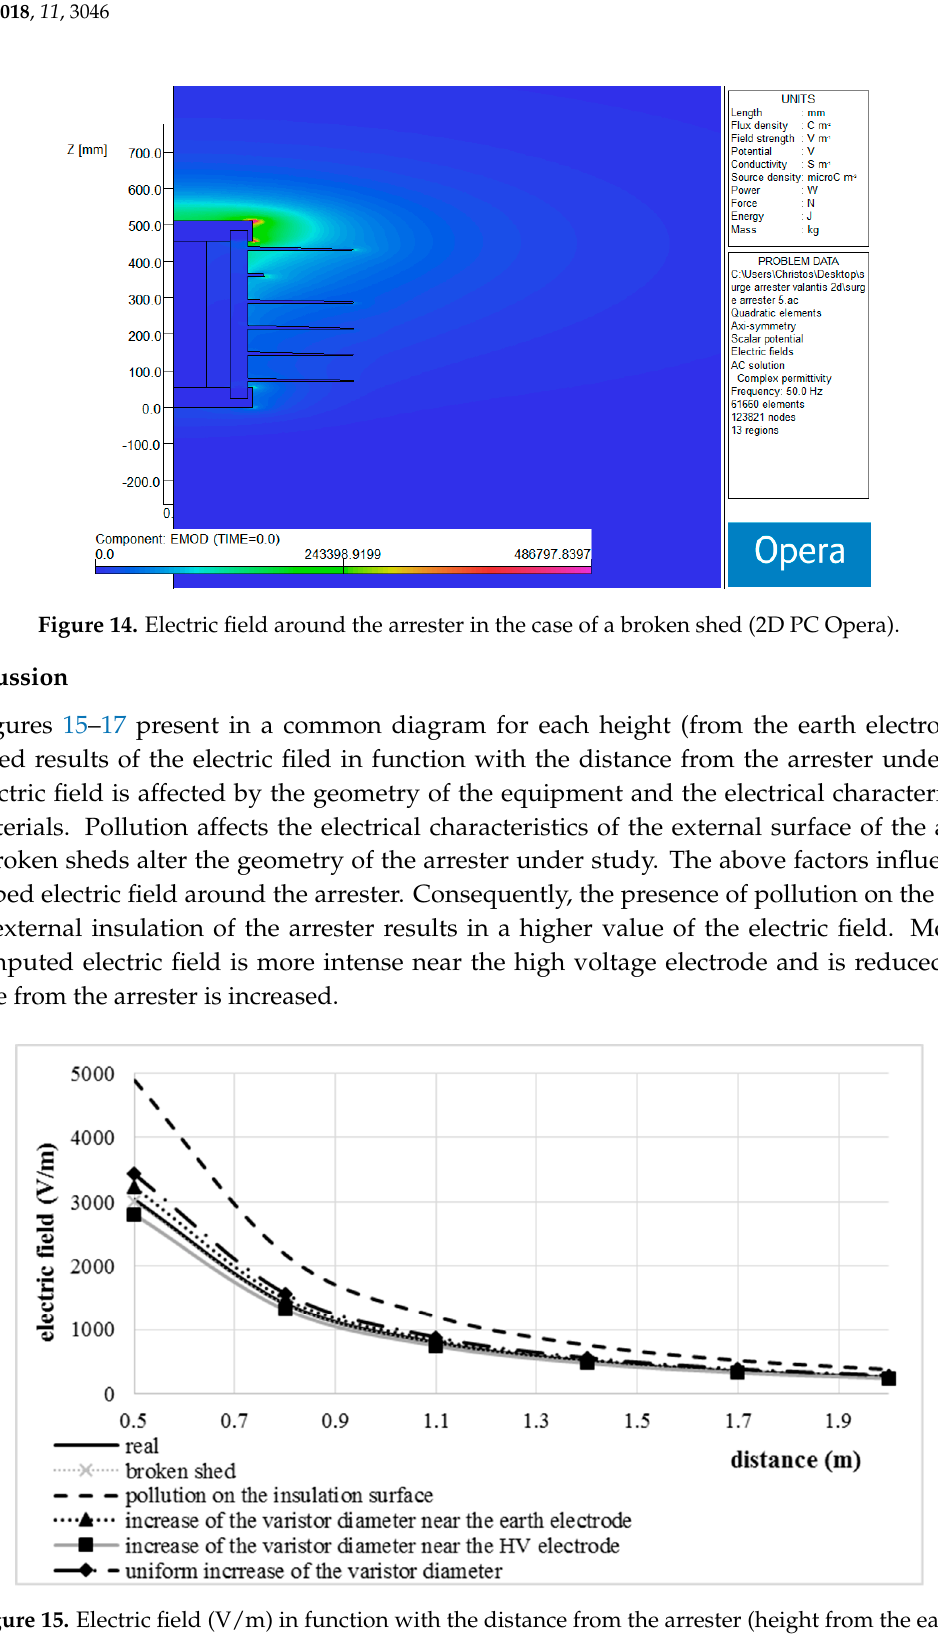
Figure 13. Electric field distribution around the arrester under study in the case of a broken shed (2D PC Opera).